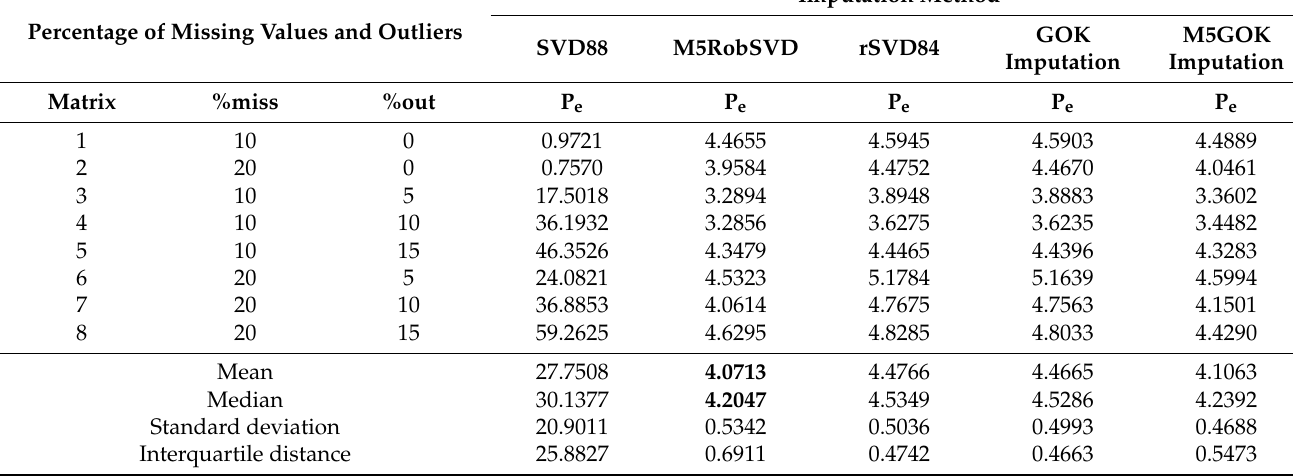
Table 2. Results of numerical example 1.